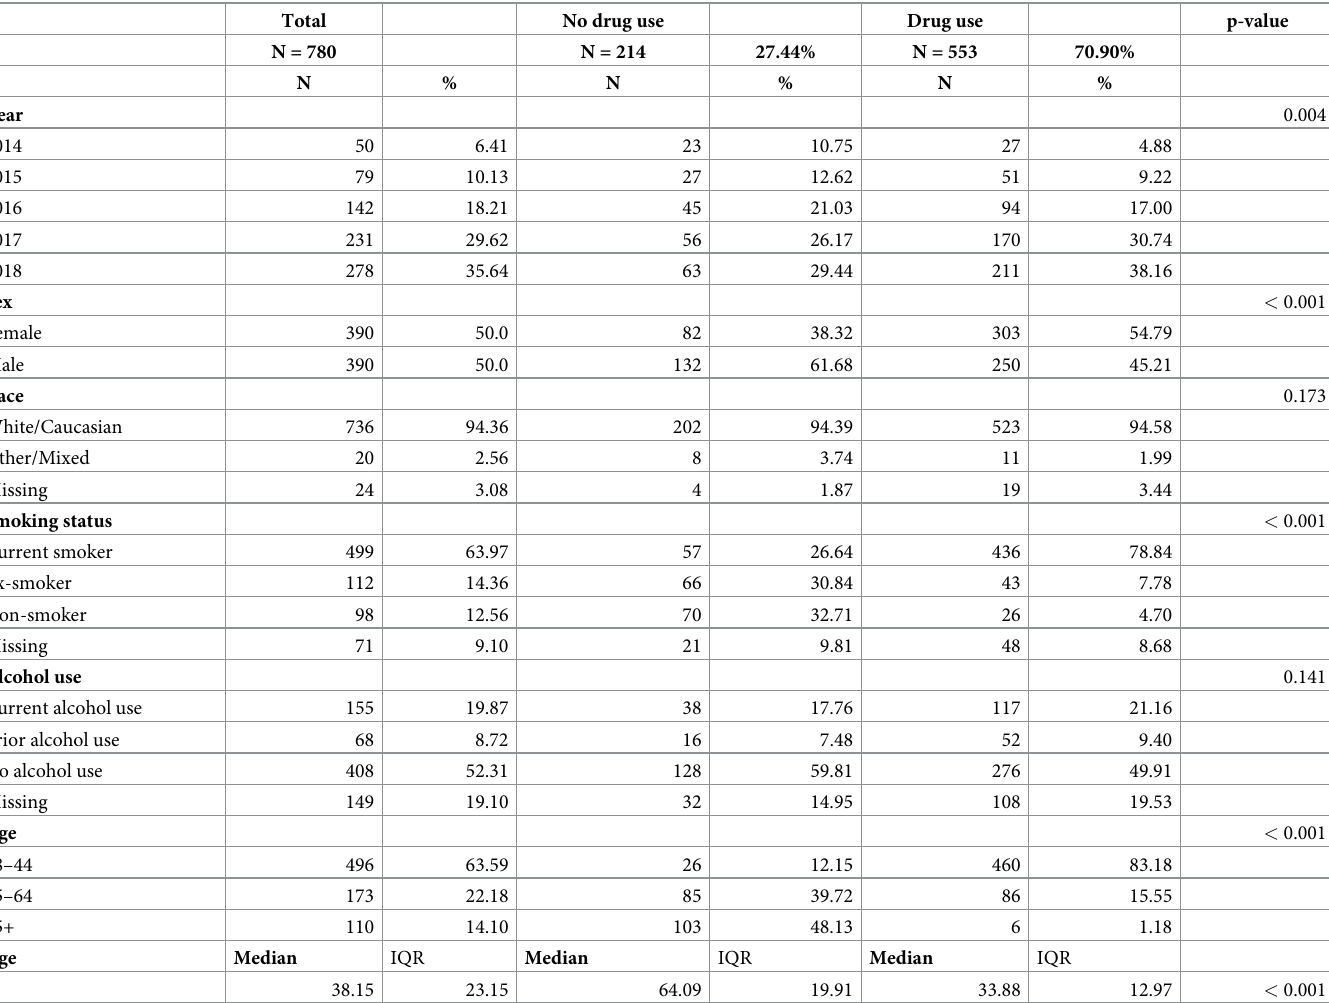
Table 1. Characteristics of patients with infective